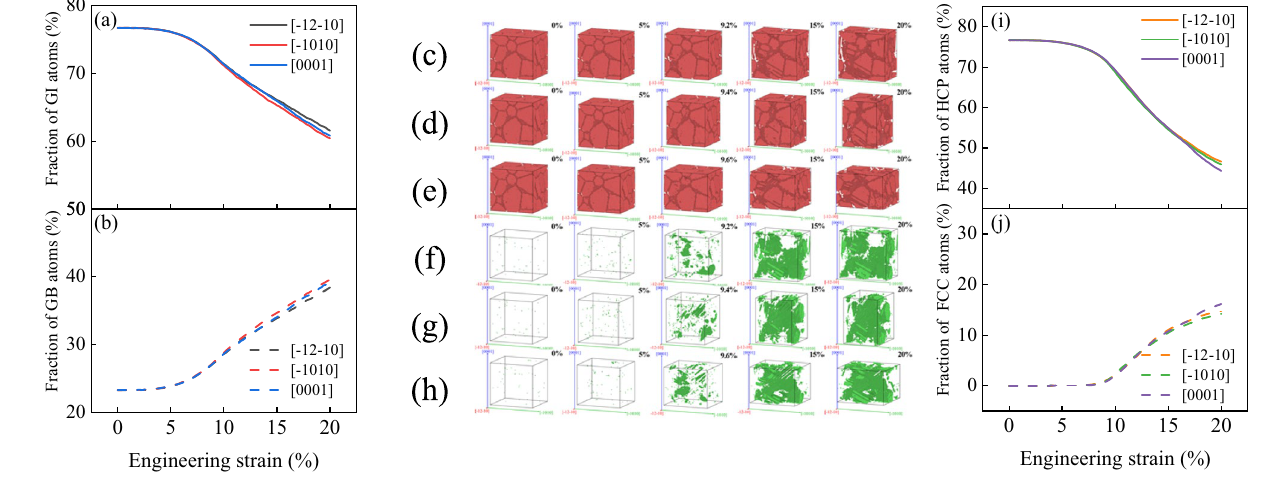
Figure 8. Phase structure change curve during compression. ( a ) Fractional curve of GI atoms; ( b ) fractional curve of GB atoms; ( c ) ~ ( e ) HCP structure evolution; ( f ) ~ ( h ) FCC structure evolution; ( i ) fractional curve of HCP structure atoms; ( j ) fractional curve of FCC structure atoms.